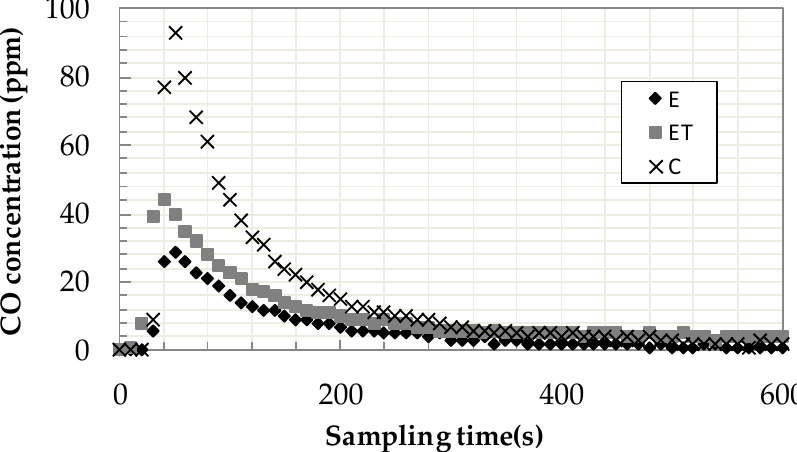
Figure 3. CO concentration (ppm) vs. sampling time (s), in a sampling example (after 45 h) (experiment 1).